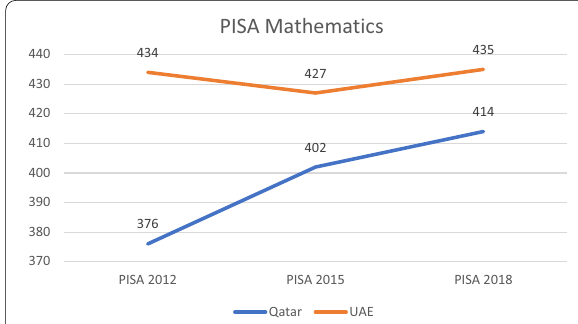
Fig. 5 PISA Mathematics performance (Qatar and the UAE)